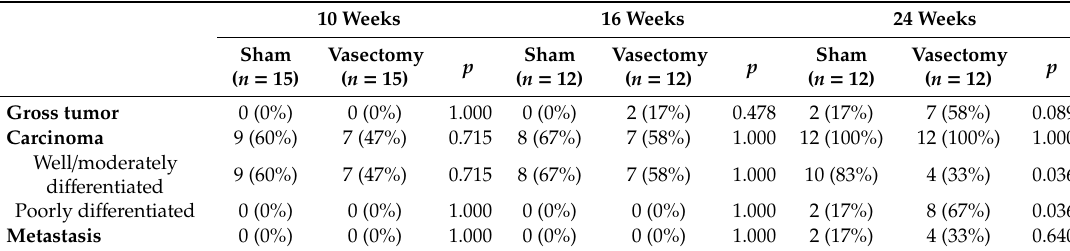
Figure 1. E ff ects of vasectomy on tumor outgrowth in TRAMP mice. ( A ) Design of Studies I and II. Vasectomy or sham surgery was performed at the age of 4 weeks. In groups of mice (Study II), bilateral orchiectomy or sham surgery was additionally performed at the age of 12 weeks. Macroscopic assessment was then performed at 10 / 16 / 24 (Study I) or 24 (Study II) weeks, and at the same time tissues were harvested for microscopic analysis. ( B ) Representative gross findings. ( C ) Representative histological findings (original magnification: × 400). ( D ) Immunohistochemistry of Ki-67 in prostate cancer (original magnification: × 200). The proliferation index (%) was determined by counting at least 500 Ki-67-positive / negative cancer cells in each mouse ( n = 2 for sham / poorly di ff erentiated at 24 weeks; n = 3 for other groups at 24 weeks). Table 1. Incidence of tumors in TRAMP